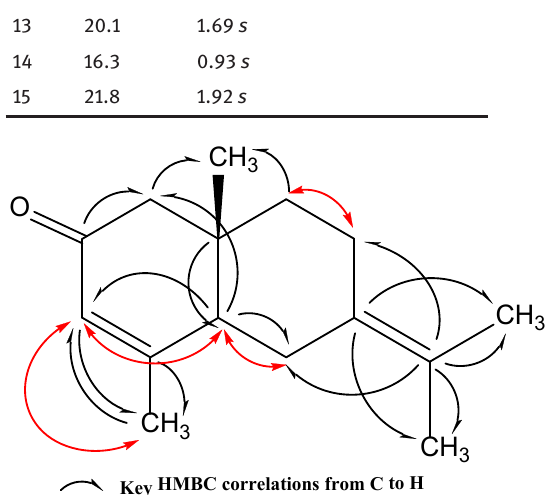
Figure 4: Key HMBC and COSY correlations of compound 1.